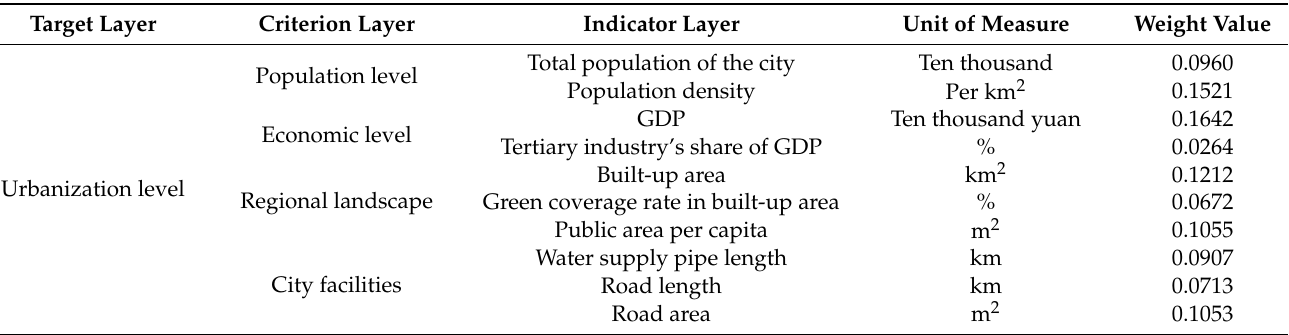
Table 3. Empowerment of the comprehensive measurement evaluation index of urbanization level